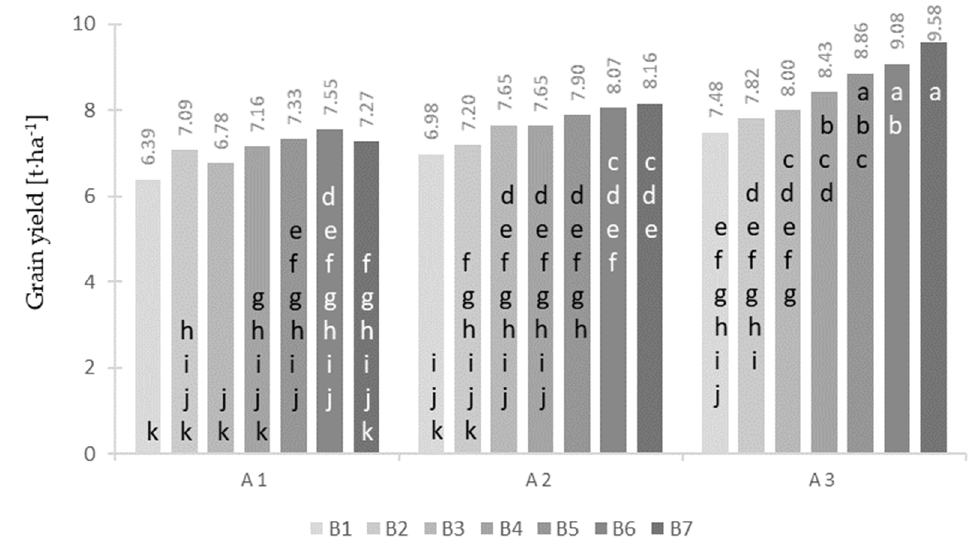
Figure 3. Average grain yield values [t · ha − 1 ] for the combination of cultivar (A) and fertilizer (B). Figure 3 . Average grain yield values [t  ha −1 ] for the combination of cultivar (A) and fertilizer (B). Values marked with at least one same letter are not significantly Values marked with at least one same letter are not significantly different.